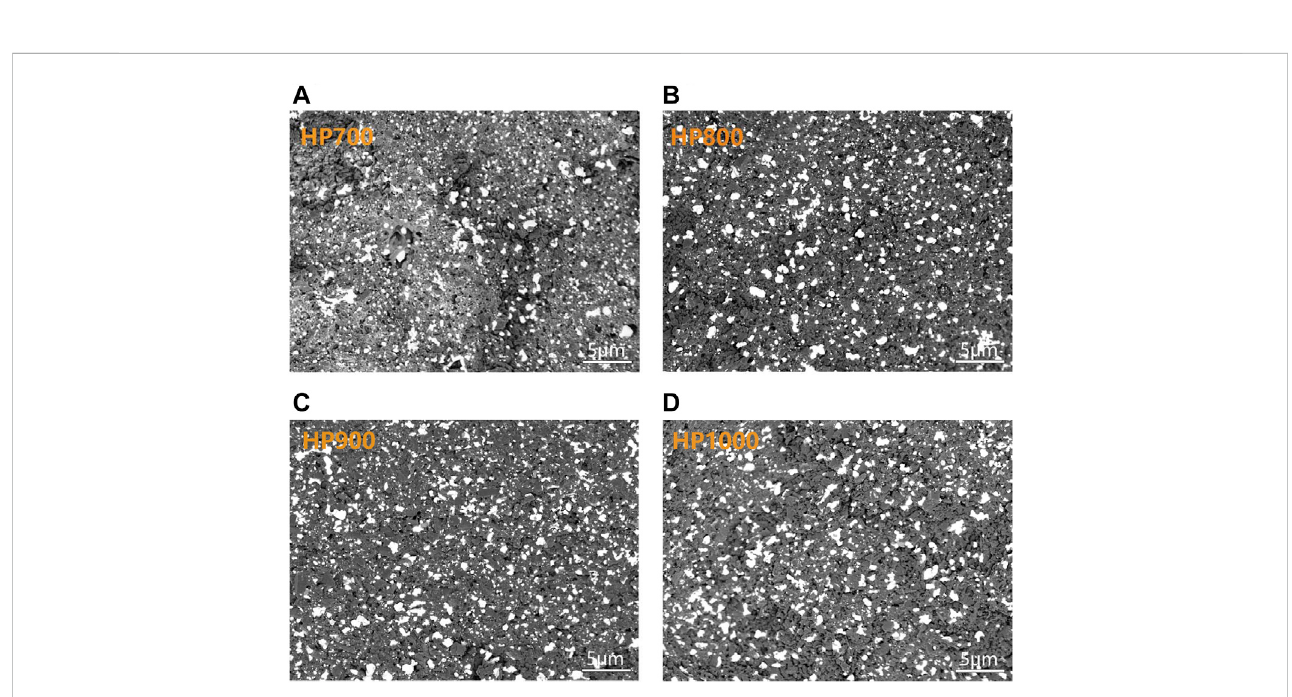
FIGURE 4 Backscattered electron (BSE) images of SiC/BBSZA composites sintered at different temperatures: (A) 700 ° C, (B) 800 ° C, (C) 900 ° C, and (D) 1,000 ° C.